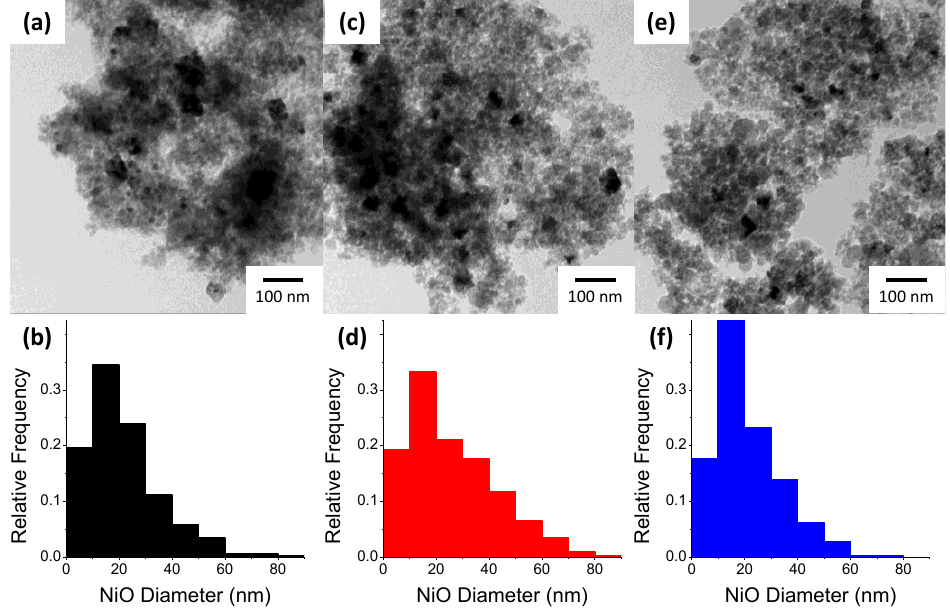
Figure 3. TEM images and corresponding NiO size distribution of ( a , b ) 3 ( c , d ) 5 and ( e , f ) 7-SiO 2 after impregnation with 5% Ni and